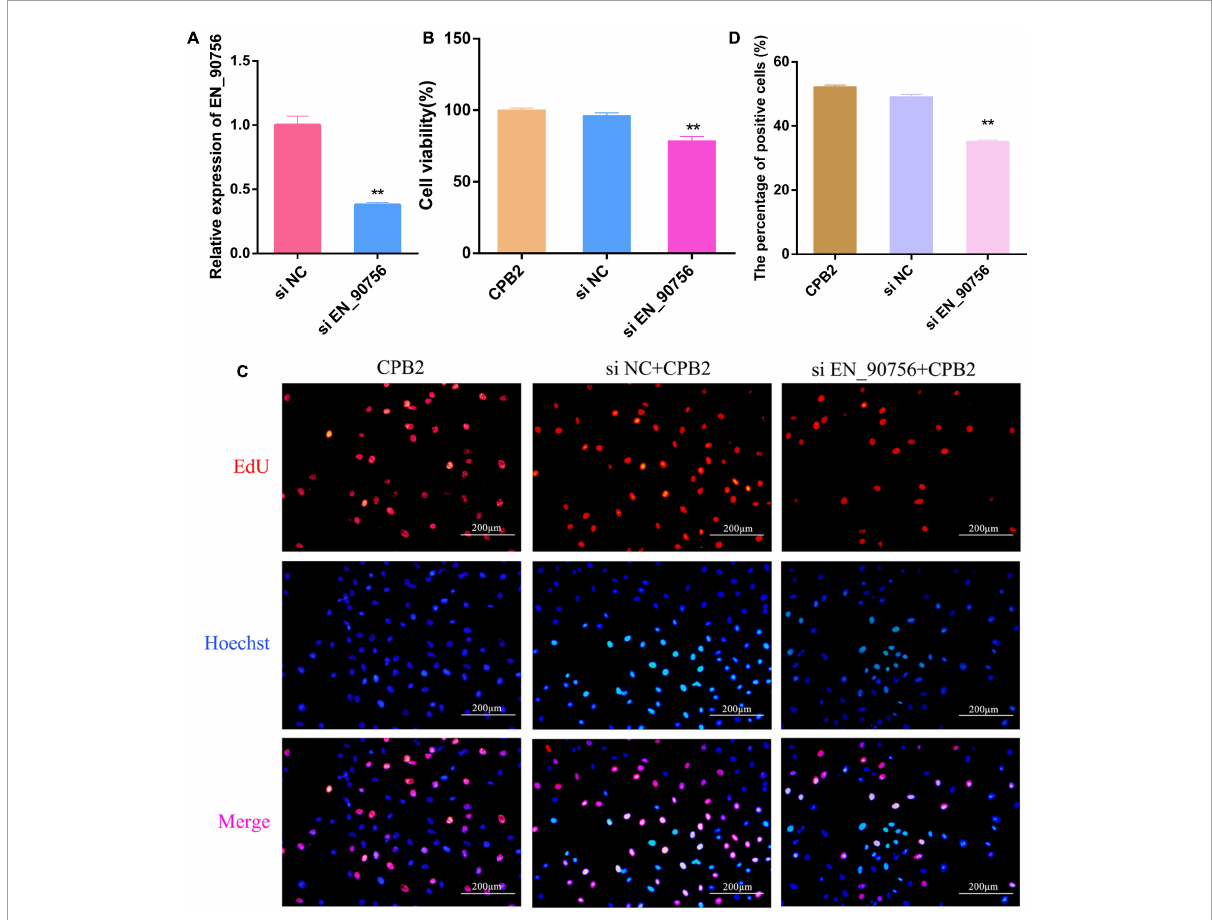
FIGURE4 Knockdown of long non-coding RNA (lncRNA) EN-90756 inhibits the proliferation of intestinal porcine epithelial cell line-J2 (IPEC-J2) cells. (A) Expression of lncRNA EN-90756 in Clostridium perfringens beta2 (CPB2) cells after transfection with si NC and si EN_90756. (B) Effect of lncRNA EN-90756 on the viability of CPB2-treated IPEC-J2 cells. (C) si NC or si EN_90756 were transfected into CPB2-treated IPEC-J2 cells, followed by staining with 5-ethynyl-2 (cid:48) -deoxyuridine (EdU) (red) for DNA replication and Hoechst (blue) for nuclei. Scale bar = 200 µ m. (D) The percentages of EdU-positive cells. ** p <